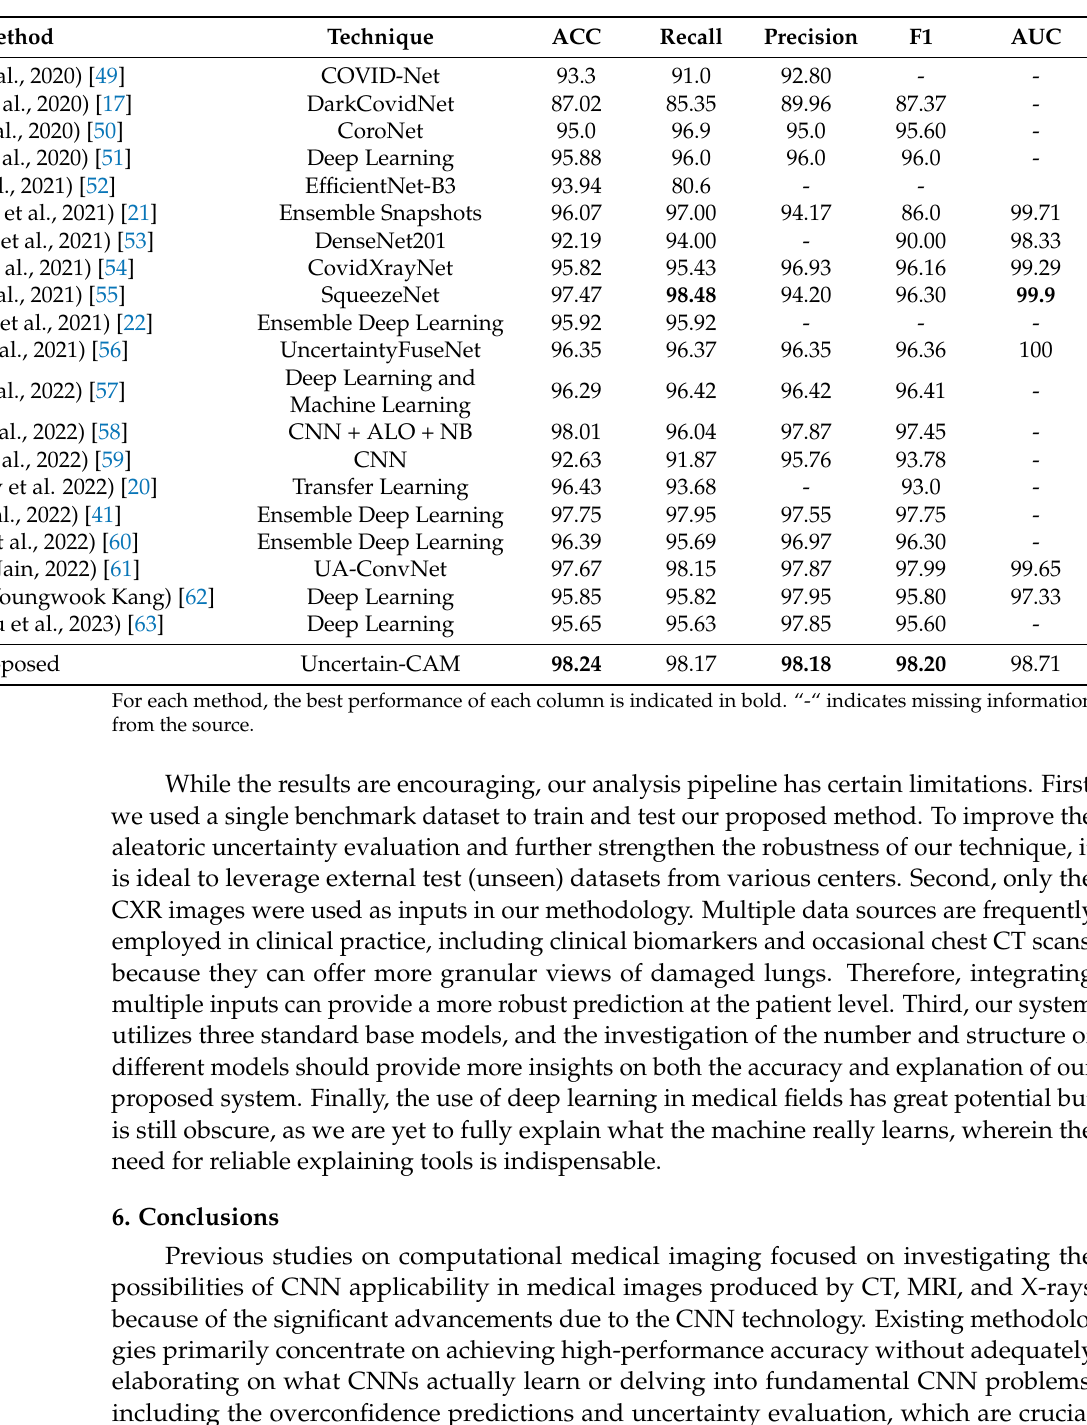
Table 7. Performance of our proposed method compared to state-of-the-art